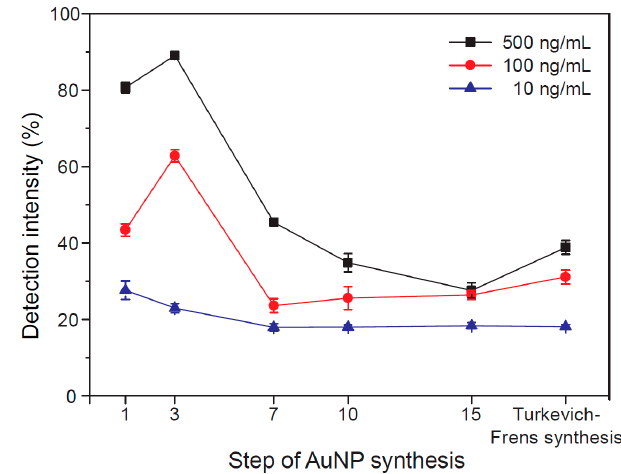
Figure 6. Color intensity at the test line of LFAs based on different-sized AuNPs and Turkevich-synthesized AuNPs.